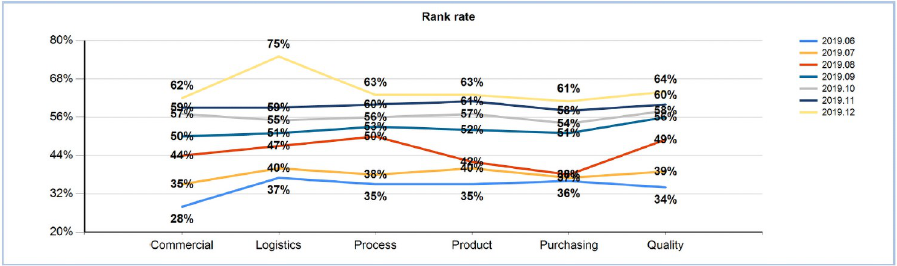
Fig 11. Monthly post function task efficiency ratio (2019.12).